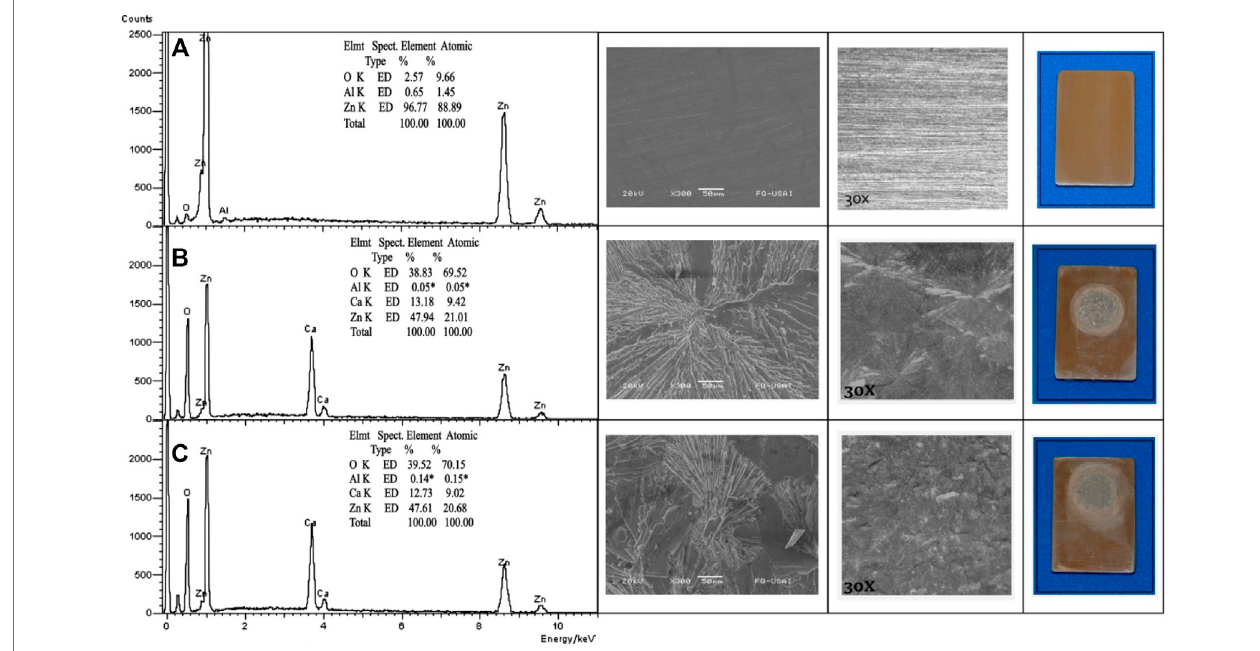
FIGURE7| EDSAnalysisandSEMmicrographs(300x)ofzincplatesinthetwotestsolutions: (A) untested, (B) after30 hwithoutchlorides, and (C) after30 hwith chlorides.